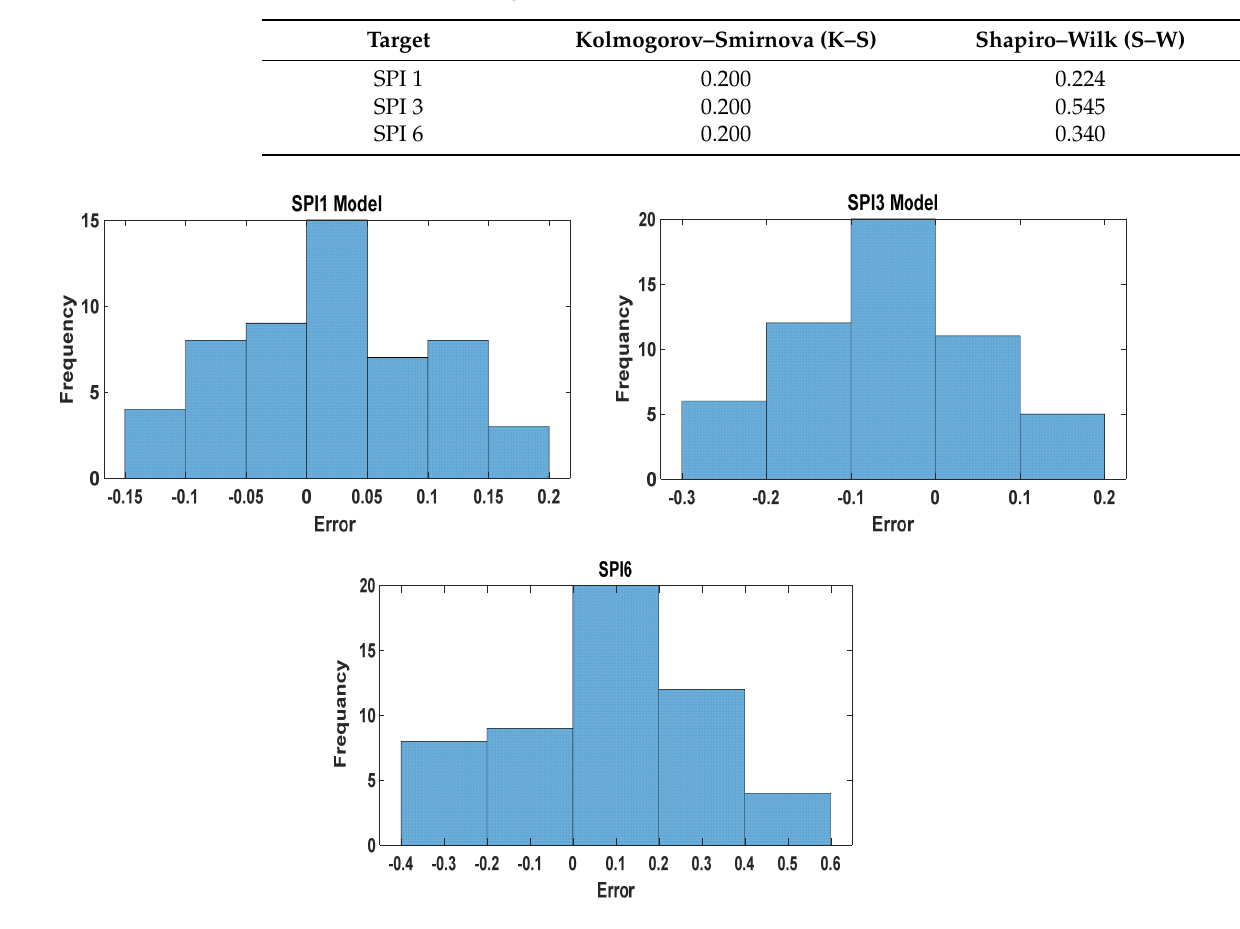
Figure 11. Normal distribution of the residual data.